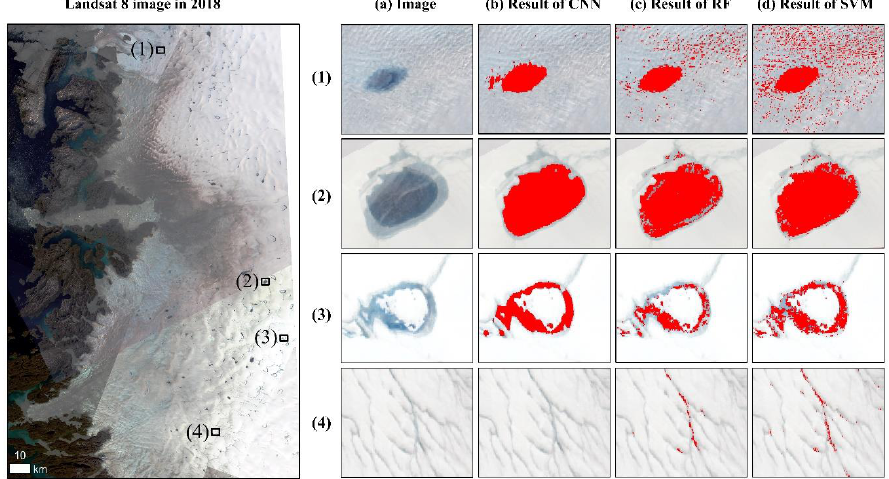
Figure 15. Detailed comparison of water identification between CNN, RF, and SVM. ( a – d ) Landsat 8 30-m true-color image from 2018 and water identification results of CNN (without morphological operations), RF, and SVM, respectively. Rows ( 1 – 4 ) stand for four detailed subregions from the subfigure on the left. Red stands for the identified